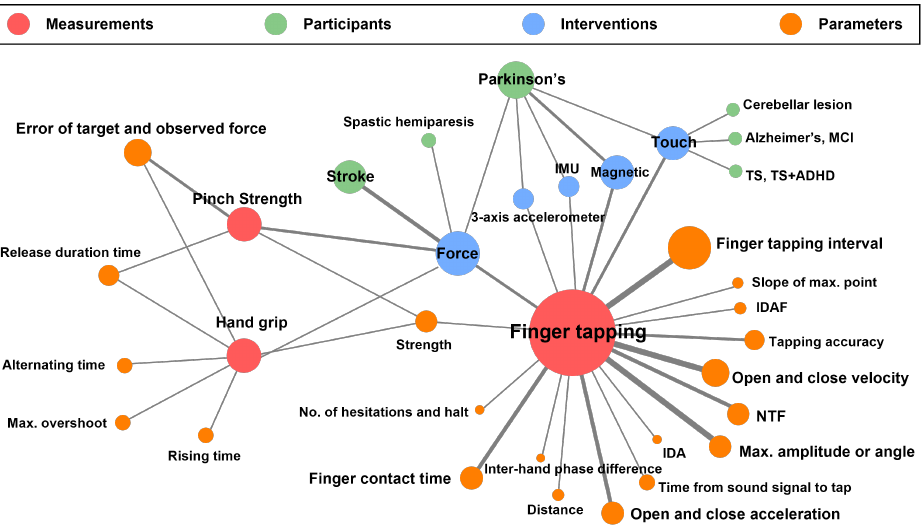
Figure 2. Visualization of degree and betweenness centralities for hand function measurement